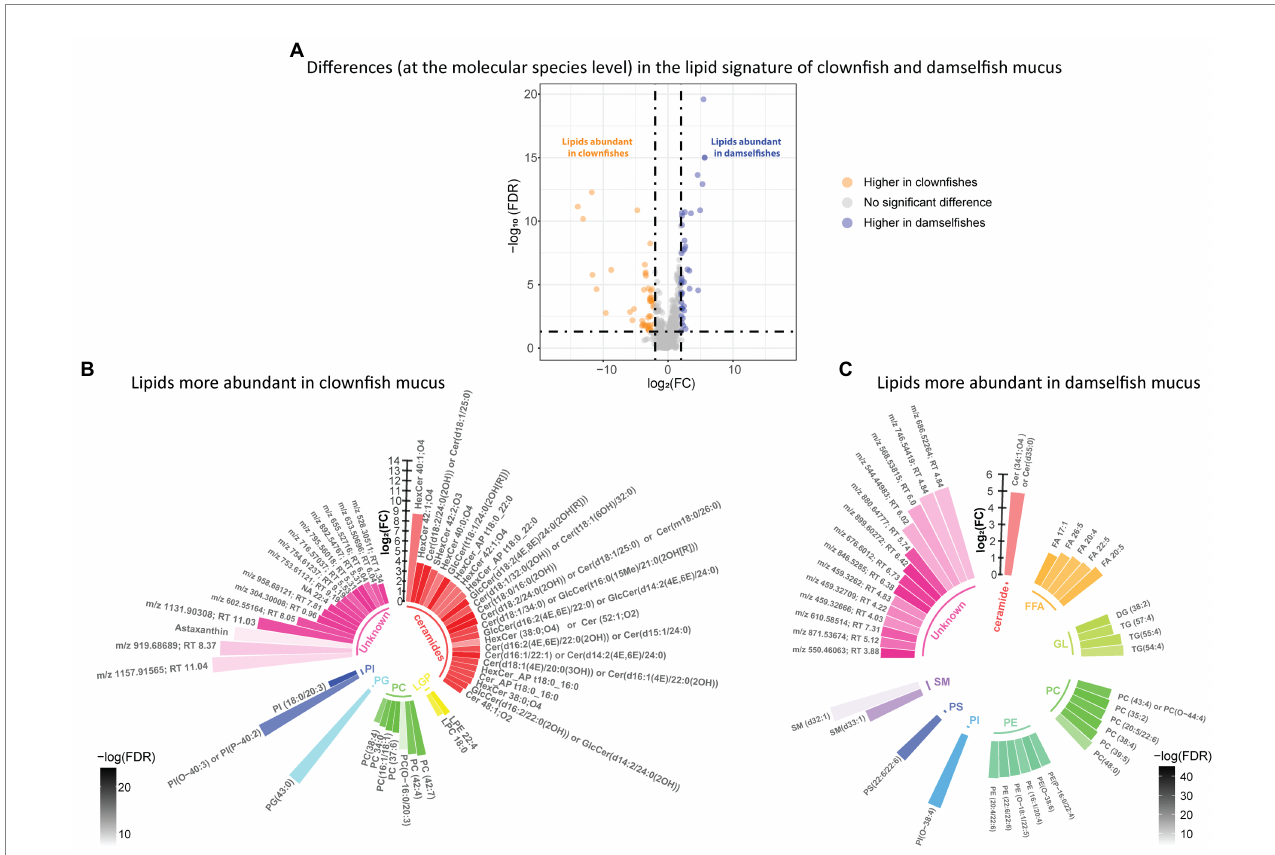
FIGURE 2 (A) Volcano plot of the global lipidome detected in the fish individuals. The log 2 (Fold change) limited at − 2 and 2 highlights the lipid features higher in clownfishes (orange) and the lipid features higher in damselfishes (purple). These lipids are subsequently represented in circular bar plots (B) and (C) to highlight the identified lipids and lipid classes differing between these two fish groups. Each colour represents a lipid class and the different shades of one colour reflect the -log(FDR) of each lipid, calculated by performing a t